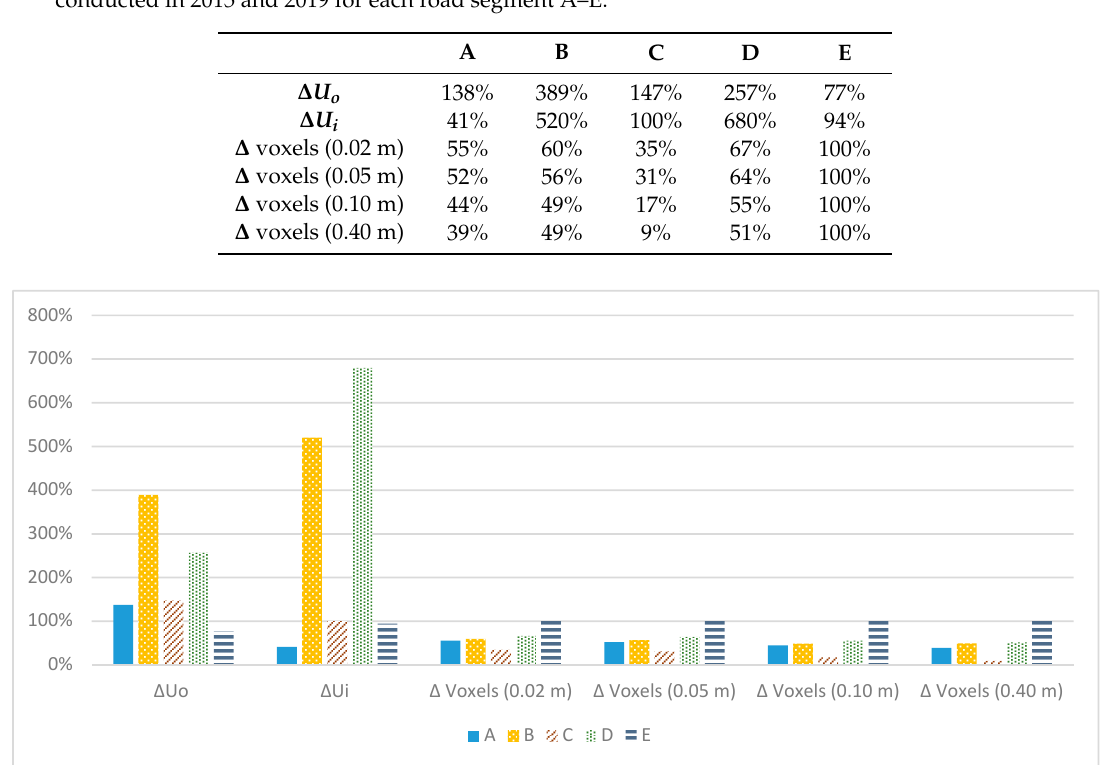
Figure 4. The absolute value of the change percentage in overall uniformity U o , longitudinal uniformity U i , and the number of occluding voxels (edge lengths: 0.02; 0.05; 0.10; 0.40 m) between the